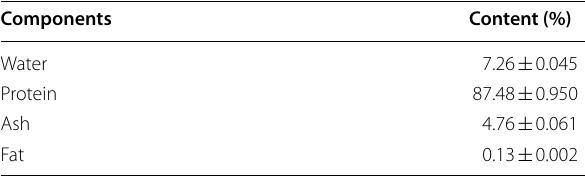
Each value represents the mean